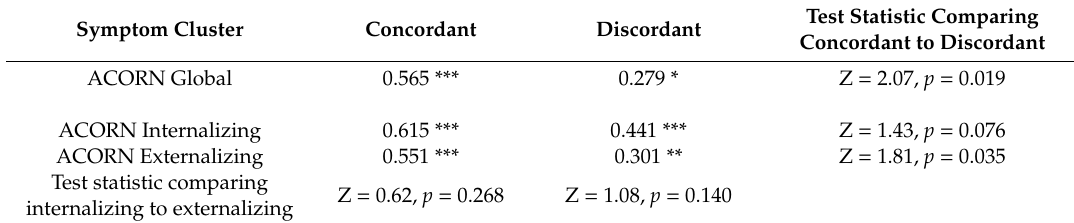
Table 3. Correlations between caregiver report and youth self-report by primary language concordance and symptom